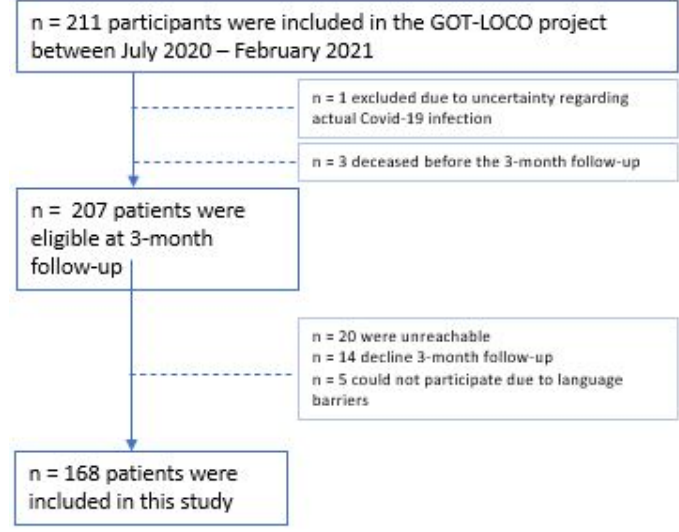
Figure 2. Flowchart of included participants in the GOT-LOCO.